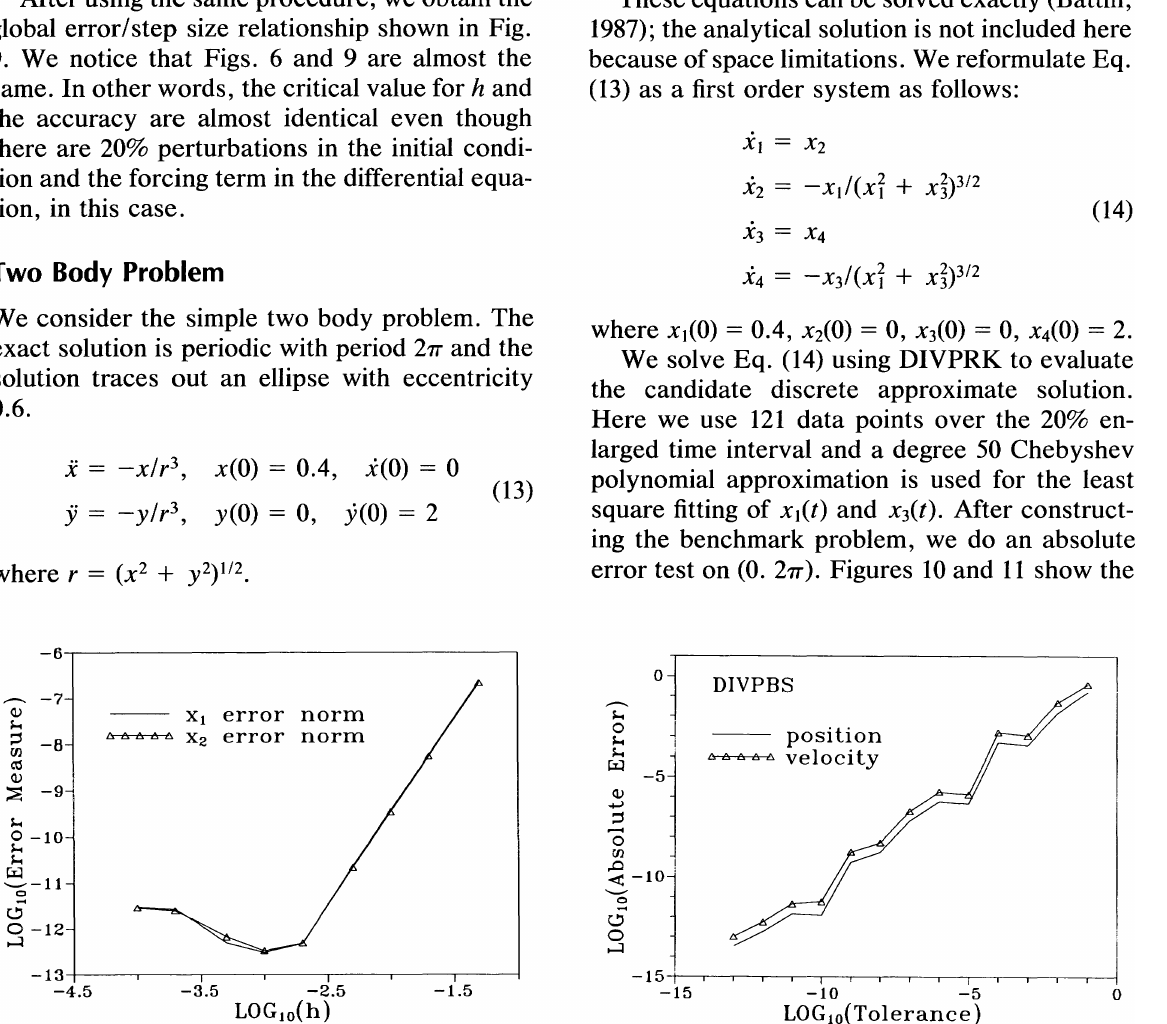
FIGURE 9 Global error vs. step size for the benchmark problem of 20% perturbations.